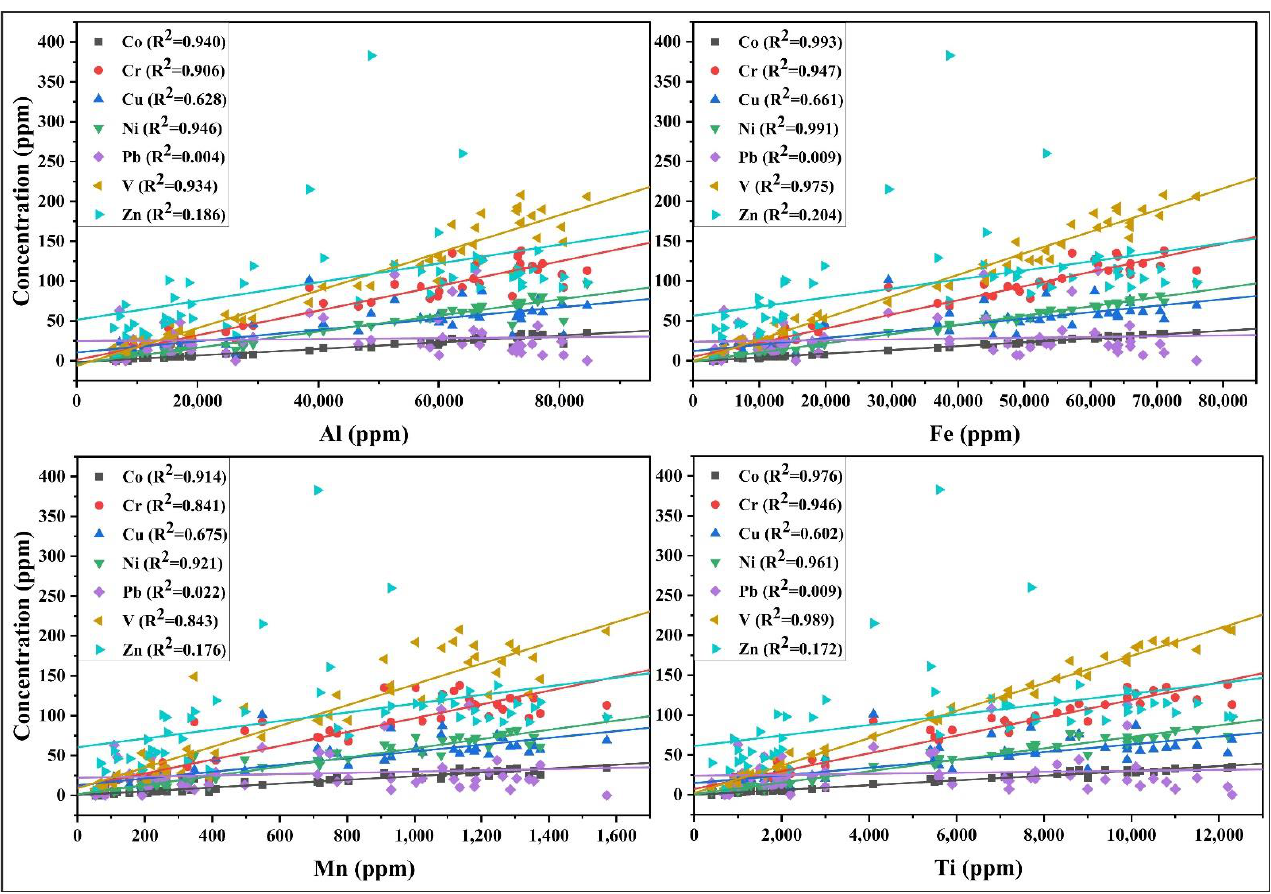
Figure 9. Scatter plot of PTEs with Al, Fe, Mn, and Ti.